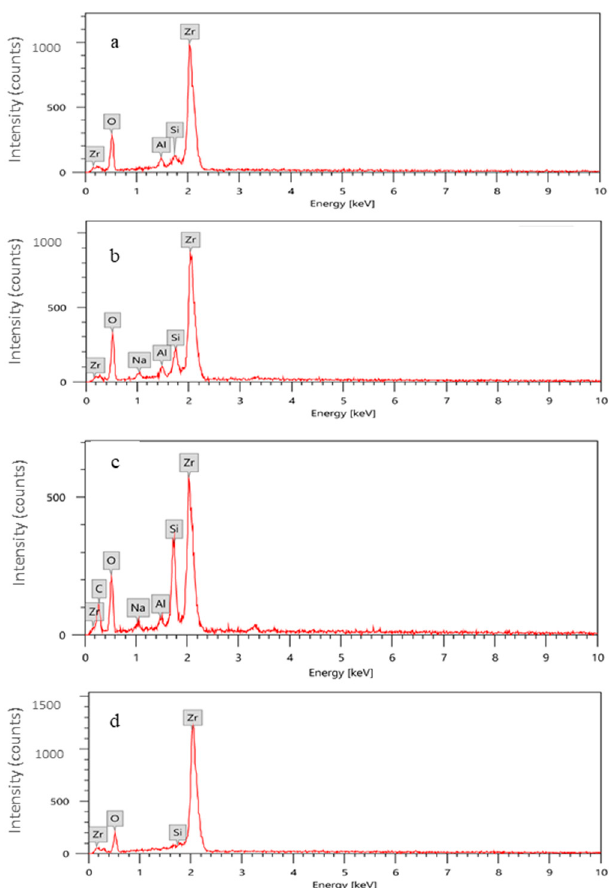
Figure 7 . Energy dispersive spectroscopy (EDS) analysis showing the percentage mass of silica in groups ( a ) CoJet (1.25 ± 0.13%), ( b ) FGC (3.42 ± 0.17%), ( c ) FGC+Nd: YAG (6.82 ± 0.21%), and ( d ) Control, where silica content was not detected.